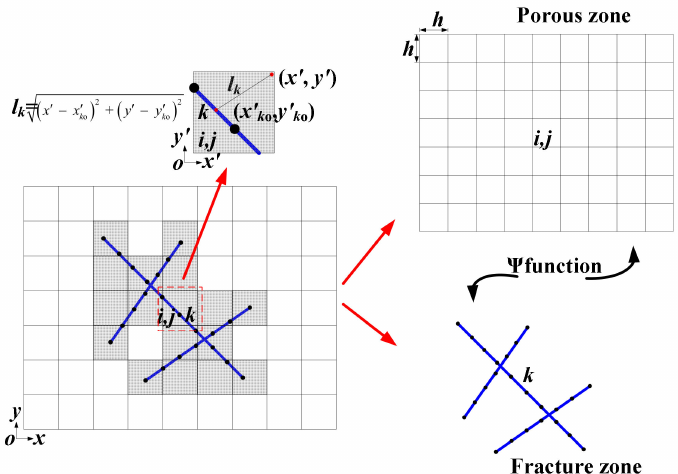
Figure 1. Schematic diagram of fractured porous